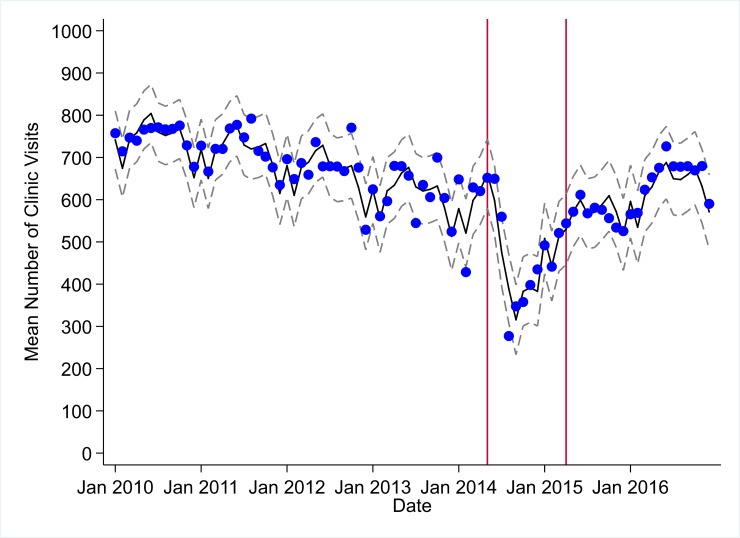
Mean trends and system losses due to Ebola virus disease (EVD) outbreak (June 2014–April 2015) for clinic visits in a census of 379 clinics providing services in Liberia from 2010–2016, excluding Montserrado County.The black solid line represents the fitted mean from a linear mixed model using a segmented regression parameterization, random intercepts and slopes by facility, monthly indicator variables to adjust for seasonality, a fixed effect to adjust for clinic-level catchment area, and an AR(1) structure to account for autocorrelation in residual errors. Gray dashed lines are 95% confidence intervals around the fitted mean. Red lines are placed at the final month before the start (May 2014) and end (April 2015) of the EVD outbreak in Liberia.